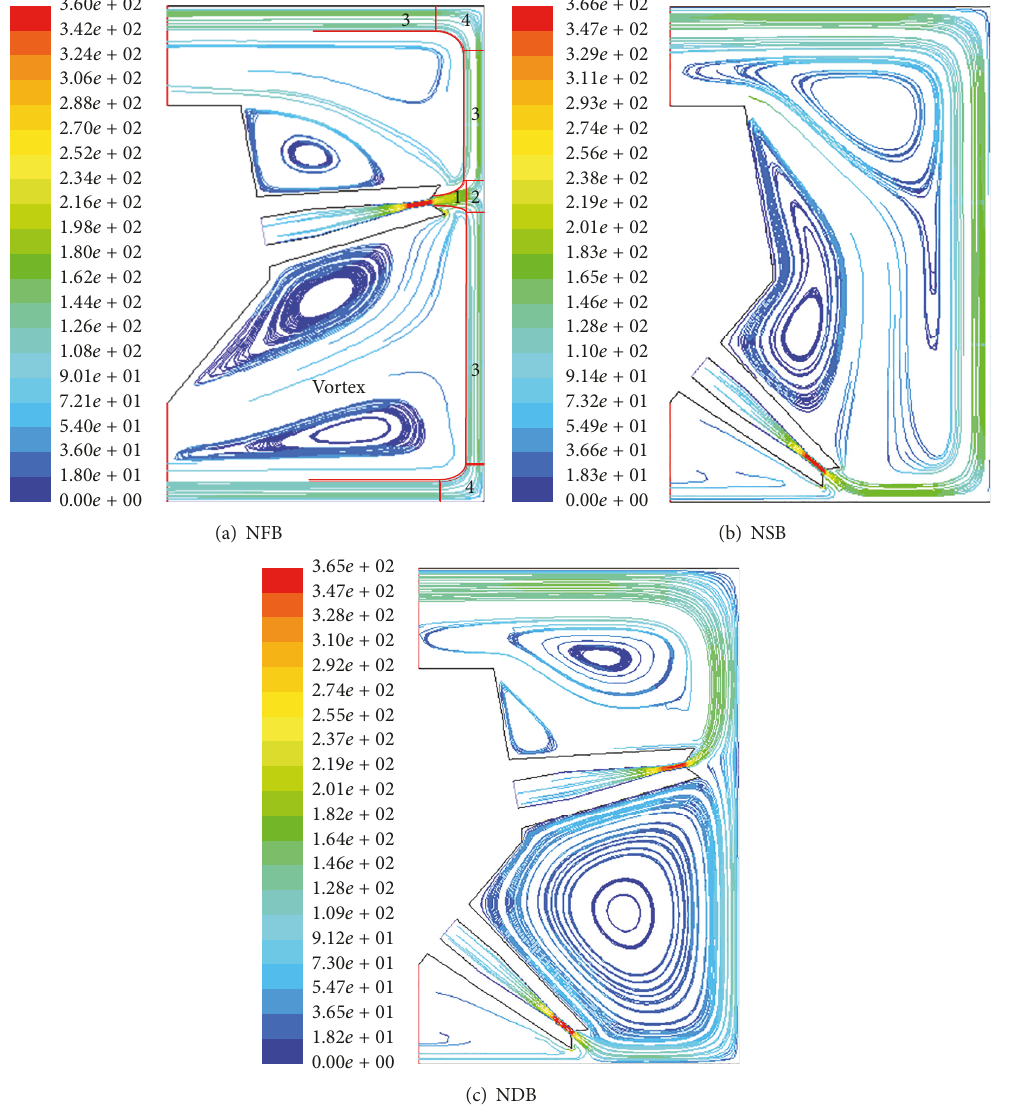
Figure 10: Distribution of velocity in flow field